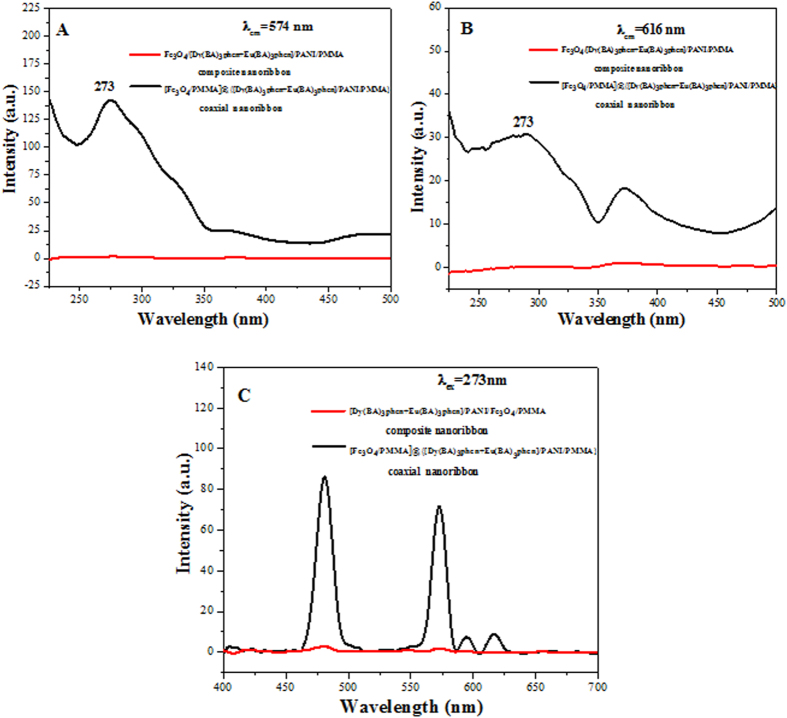
Excitation spectra (A,B) and emission spectra (C) of [Fe3O4/PMMA]@{[Dy(BA)3phen+Eu(BA)3phen]/PANI/PMMA} coaxial nanoribbons (Sa3@Sb1) and Fe3O4/[Dy(BA)3phen+Eu(BA)3phen]/PANI/PMMA composite nanoribbons.